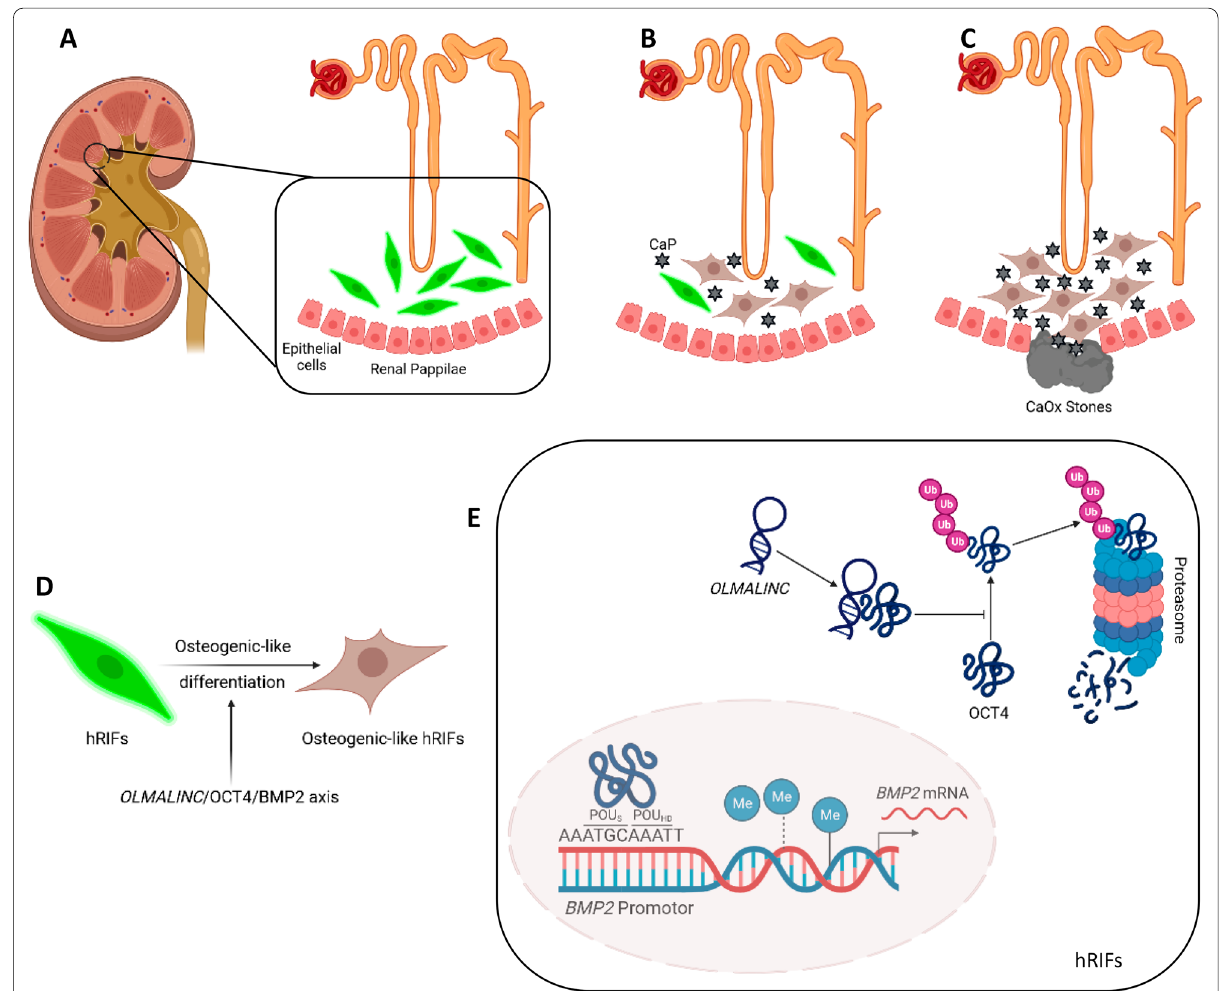
Fig. 7 Schematic illustration of the possible involvement of OLMALINC /OCT4/ BMP2 axis mediated osteogenic-like differentiation of human renal interstitial fibroblasts (hRIFs) in Randall’s Plaque formation. A A normal renal papilla in which Henle loop, hRIFs, and epithelial cells are shown. B HRIFs adopt an osteogenic-like phenotype and calcium phosphate (CaP) deposits are formed in renal interstitium of renal papilla. C CaP deposits aggregate and impair the musca of renal papilla, leading to RP formation as an anchor for calcium oxalate (CaOx) crystals to induce stone formation. D, E The molecular mechanism in the osteogenic-like differentiation of hRIFs based our findings. OCT4 bound to the sequences (AAA TGC AAATT) in BMP2 promoter where the POU-specific domain (POU S ) and the POU homeodomain (POU HD ) recognized and bound to ATGC and AAAT respectively, and decreased the DNA methylation of BMP2 promoter to transcriptionally promote BMP2 expression. OLMALINC stabilized OCT4 to enhance osteogenic-like differentiation of hRIFs via disrupting its ubiquitination. This illustration was created with